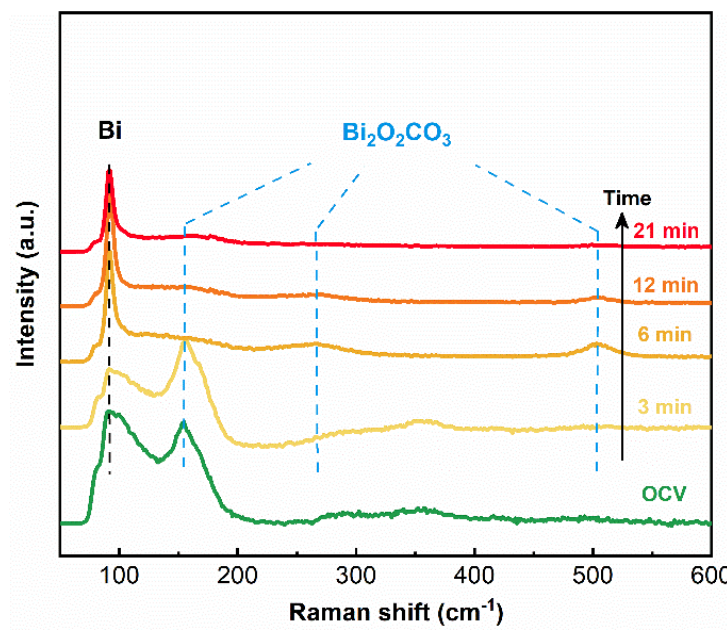
Figure 3. In-situ Raman spectra of Bi 2 O 2 CO 3 @Bi/CP during the electrochemical reduction of CO 2 at − 0.90 V vs. RHE in the CO 2 saturated 0.50 M KHCO 3 electrolyte. To study the electrochemical CO 2 RR performance of the obtained catalysts, linear sweep voltammetry (LSV) measurements were conducted from − 0.3 to − 1.2 V vs. RHE in the CO 2 saturated 0.50 M KHCO 3 electrolyte. As shown in Figure 4a, the CO 2 RR Faradaic onset potential is observed at − 0.56 and − 0.76 V vs. RHE for the Bi 2 O 2 CO 3 @Bi/CP and the Bi/CP electrode in the CO 2 saturated 0.50 M KHCO 3 electrolyte, respectively. In addition, the onset potential of HER on carbon paper is − 0.84 V vs. RHE. The lower onset potential of Bi 2 O 2 CO 3 @Bi/CP manifests a higher CO 2 reduction activity, indicating that introducing Bi 2 O 2 CO 3 into Bi-based catalysts is favorable to CO 2 RR. The total current density (J tot ) of the Bi 2 O 2 CO 3 @Bi/CP electrode is ~20 mA cm − 2 at − 1.07 V vs. RHE, which is much higher than those in the N 2 − saturated condition and sufficiently demonstrates the CO 2 RR activity (Figure S7). The cyclic voltammetry curves in Figure 4b and S8 exhibit an oxidation peak at ~0.31 V and a reduction peak at ~0.12 V, which can be attributed to the Bi 3+ /Bi 0 redox process in the Bi 2 O 2 CO 3 @Bi/CP electrode, and another reduction peak at a more negative potential ( − 0.90 V) is assigned to the electrochemical CO 2 reduction or competitive H 2 evolution. The as-prepared Bi 2 O 2 CO 3 @Bi/CP electrode revealed a high interface resistance, leading to a relatively low current density during the initial CV cycles. After several redox cycles, the adsorbed impurities, such as inert gas on the surface of the electrode, have been removed and the catalytic interface became dynamically stable, and thus the CV current density reached the maximum. After that, the Bi 2 O 2 CO 3 composite in the electrode gradually reduced during the negative potential and the current density decreased. The redox peaks still remained after 50 cycles, which indicates the stability of the Bi 2 O 2 CO 3 @Bi interfaces and is in accordance with the previous reports [53,54]. Meanwhile, an observable positive shift in the reduction peak was recorded on the CVs curves, which was attributed to the conversion of Bi–O or Bi=O to Bi–Bi bonds